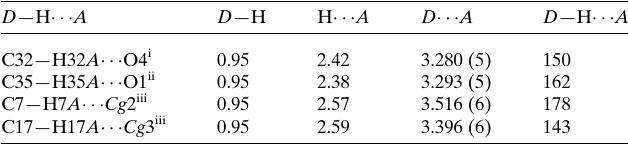
Table 1 Selected geometric parameters (A˚ , (cid:3) ).